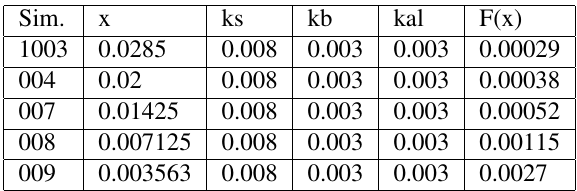
Table 7. Simulation parameters